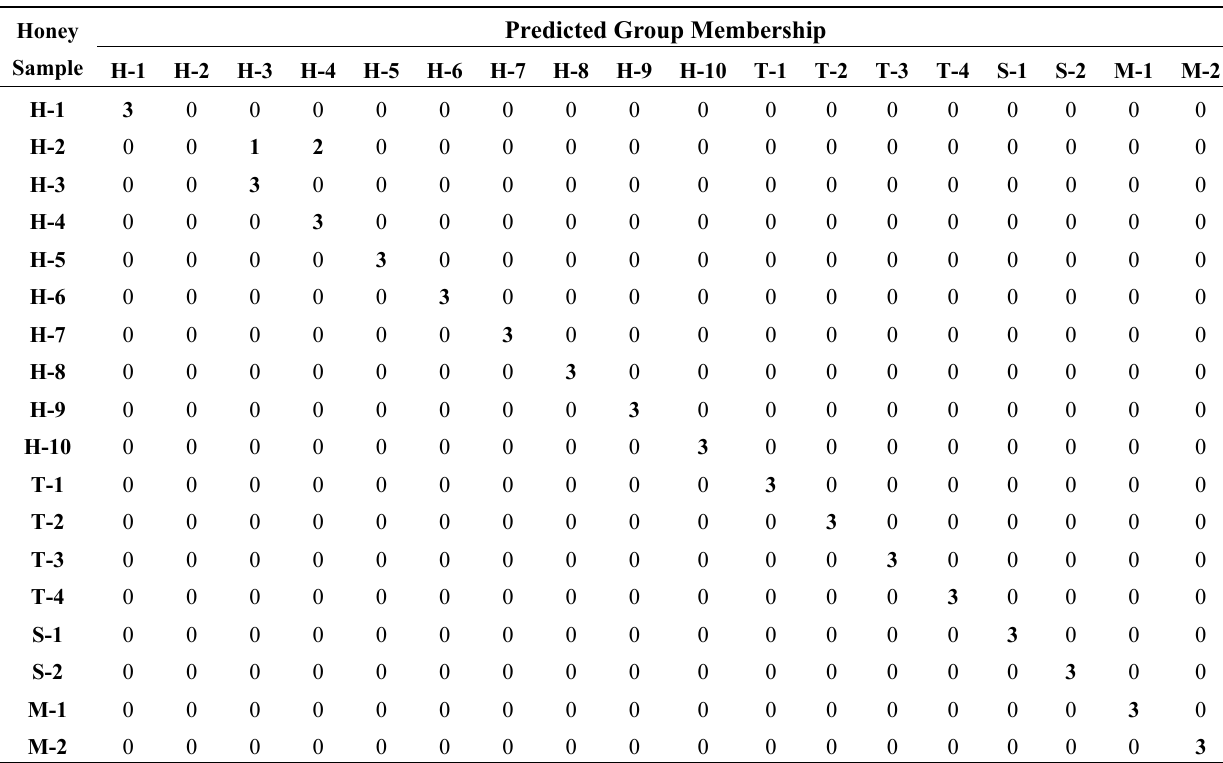
Table 8. Detailed PNN classification results on sensor fusion with features selection and spread size of 0.001.